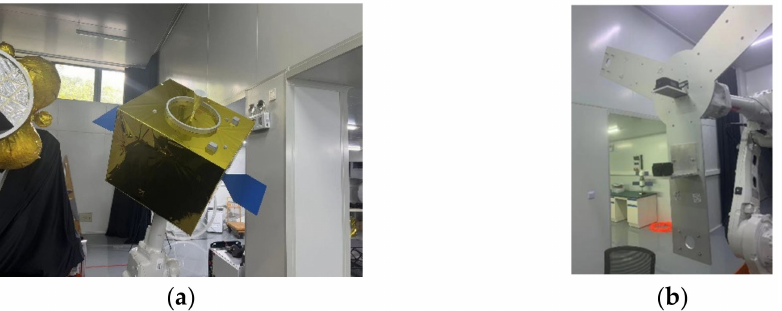
Figure 7. Experimental environment setup. ( a ) Non-cooperative satellite model; ( b ) TOF camera installed on the service spacecraft.